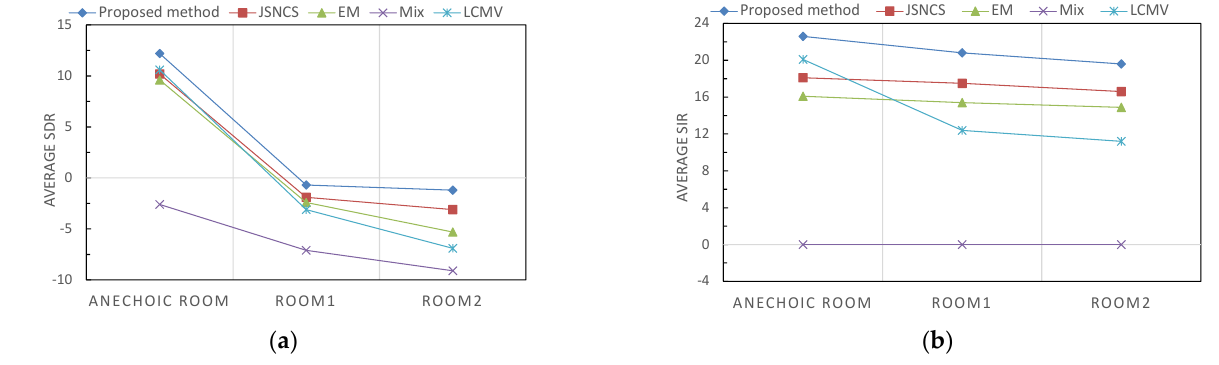
Figure 12. Average SDR and SIR in different reverberant rooms: ( a ) average SDR; ( b ) average SIR.